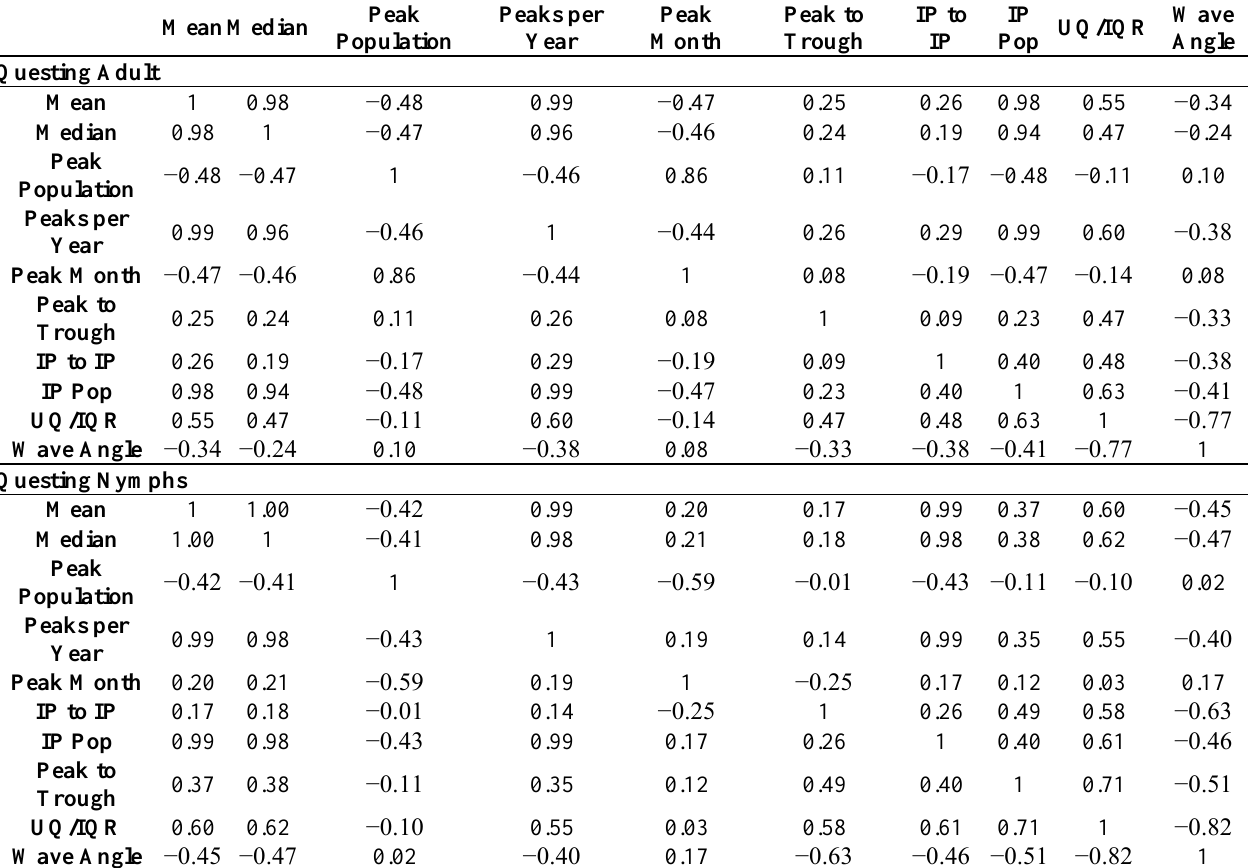
Table 2. Spearman correlation coefficients (r for each questing life stage under the baseline climate